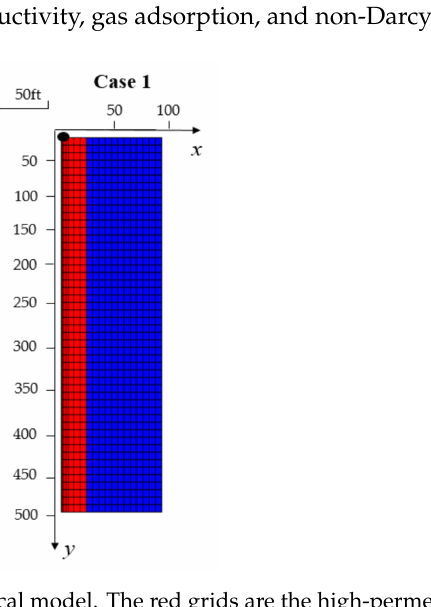
Figure 2. Reservoir grid for the numerical model. The red grids are the high-permeability region and the blue ones are the low-permeability region. Table 1. Summary of input parameters for the synthetic numerical